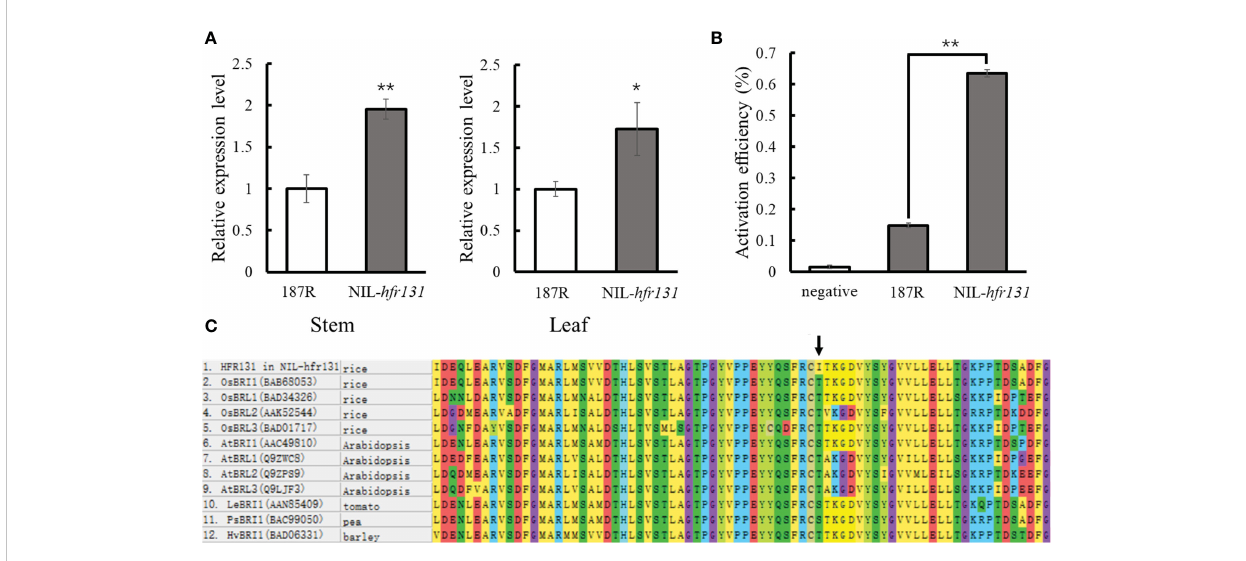
FIGURE 4 Analysis of the effective mutation site. (A) Expression level of HFR131 in the stem and leaf of 187R and NIL- hfr131 . (B) Detection of promoter activity. Activation ef fi ciency was calculated as LUC/REN. (C) Alignment of a portion of the kinase domain of Arabidopsis thaliana , rice, tomato, pea, and barley BRI family members. The arrow indicates the mutation site. * P < 0.05, ** P <